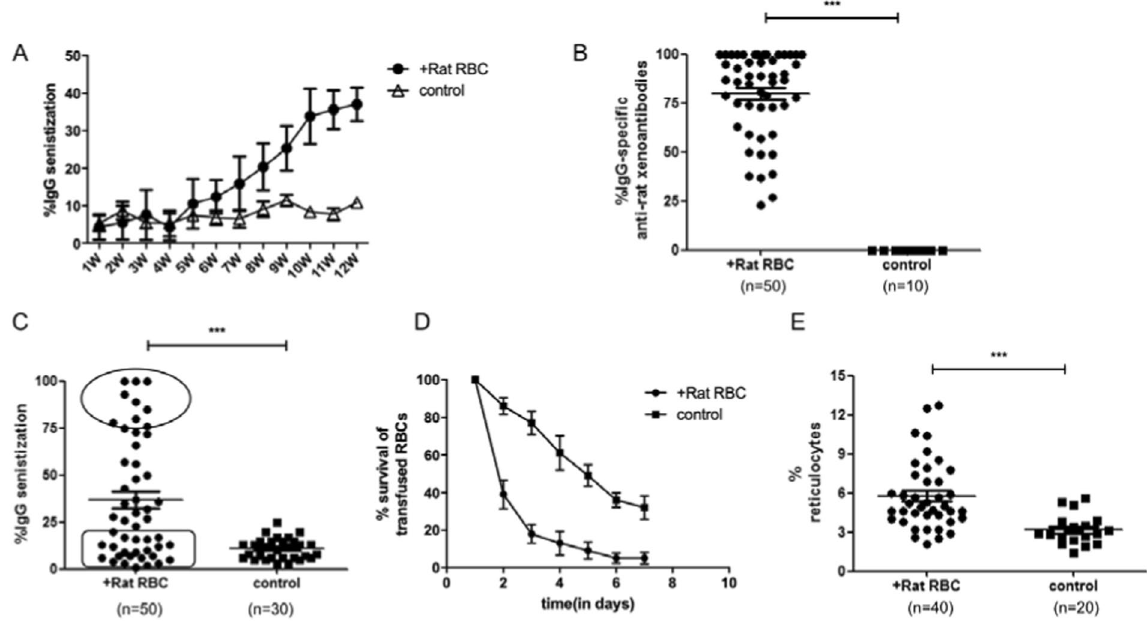
Figure 1. Development of the AIHA mouse model. Female C57BL/6J mice aged 8-10 weeks were immunized on a weekly basis with rat RBCsfor 12 weeks. ( A ) Level of IgG-specific autoantibodies on mouse RBCs was measured by flow cytometry on the day before rat RBCs injection and expressed as percentage of background unstained cells. This experiment was repeated three times with at least 10 mice for each group each time. ( B ) Levels of IgG-specific anti–rat xenoantibodies in plasma were measured by first incubating rat erythrocytes with diluted mouse plasma followed by staining with FITC-conjugated anti–mouse IgG. The analysis was performed by flow cytometry and the percentage of rat RBCs that have antibodies bound to them is shown on the Y-axis. ( C ) Theexpression of IgG-specific autoantibodies on mouse RBCs at week 12. Each plot represents one mouse in each group. The oval box represents the cohort with the highest levels of autoantibodies, whereas the square box includes the group with background control levels of autoantibodies. ( D ) Red cell survival studies were performed using PKH-26 labeled C57BL/6J mouse RBCs transfused into mice immunized with rat RBCs or PBS as a negative control.At times indicated, venous blood was sampled and analyzed by flow cytometry for the fraction of fluorescent RBCs. To show the RBCs clearance kinetics, detectable RBCs at 1 minute after injection were defined as 100%, and the remaining RBCs were calculated at different time points by divided the total RBCs. This experiment was repeated three times with two mice in each group. ( E ) Numbers of circulating reticulocytes in mice expressed as a percentage. Data shown were the mean ± SEM. The horizontal lines show the